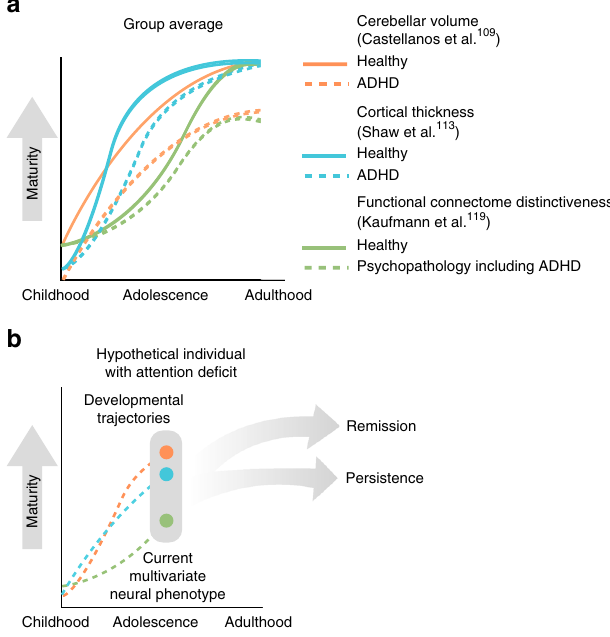
Fig. 4 a Developmental changes in cerebellar volume, cortical thickness, and functional connectome distinctiveness in healthy individuals and individuals with attention de fi cits. Curves are based on data from refs. 109,113,119 . b Developmental changes in a hypothetical adolescent with attention de fi cits. A model trained to use the developmental trajectories of multiple brain measures to predict future outcomes may best characterize whether this individual ’ s de fi cits will improve, persist, or worsen. These predictions may have implications for future treatment or cessation